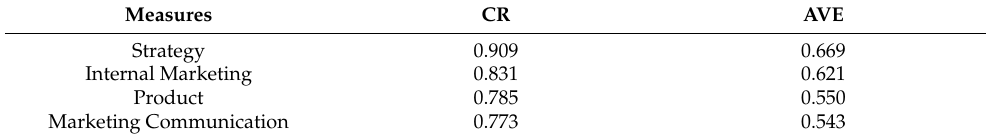
Table 6. Compound reliability (CR) and average variance extracted (AVE) of the measures.